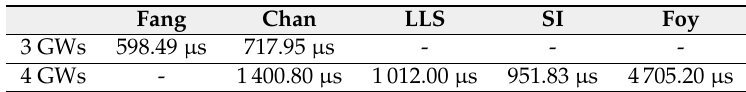
Computation time comparison between Fang, Chan, linear least-squares (LLS), spherical-intersection (SI), and Foy algorithms [34]. Fang Chan LLS SI Foy 3 GWs 598.49 µ s 717.95 µ s - - - 4 GWs - 1400.80 µ s 1012.00 µ s 951.83 µ s 4705.20 µ